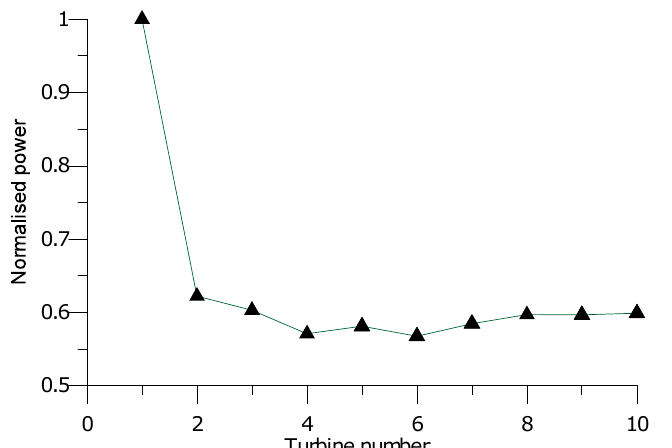
Figure 9. Normalized power along Horns Rev wind farm